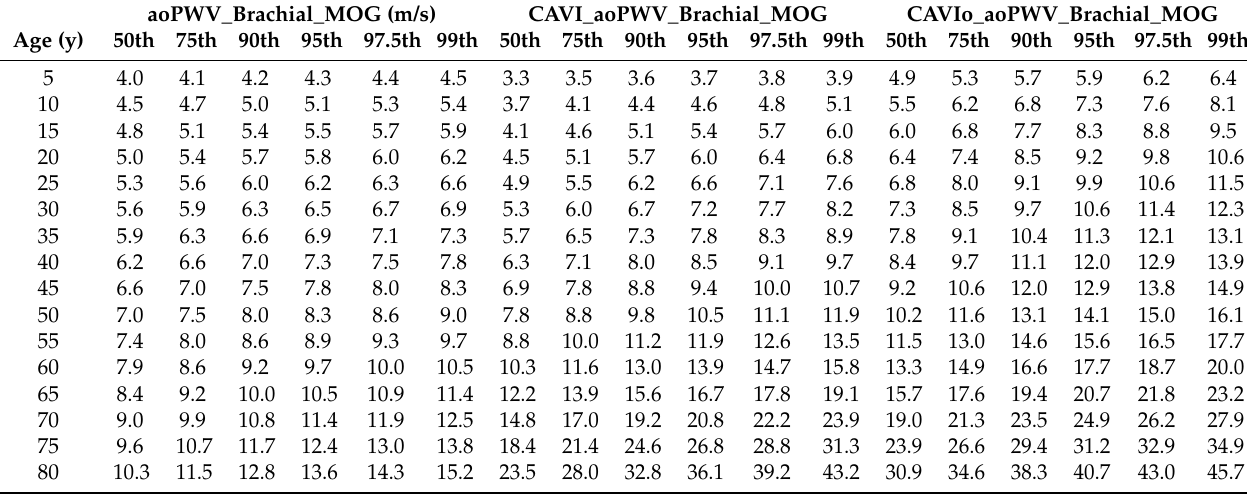
Table 12. aoPWV_Brachial_MOG levels and related parameters (CAVI and CAVIo) reference intervals: All.